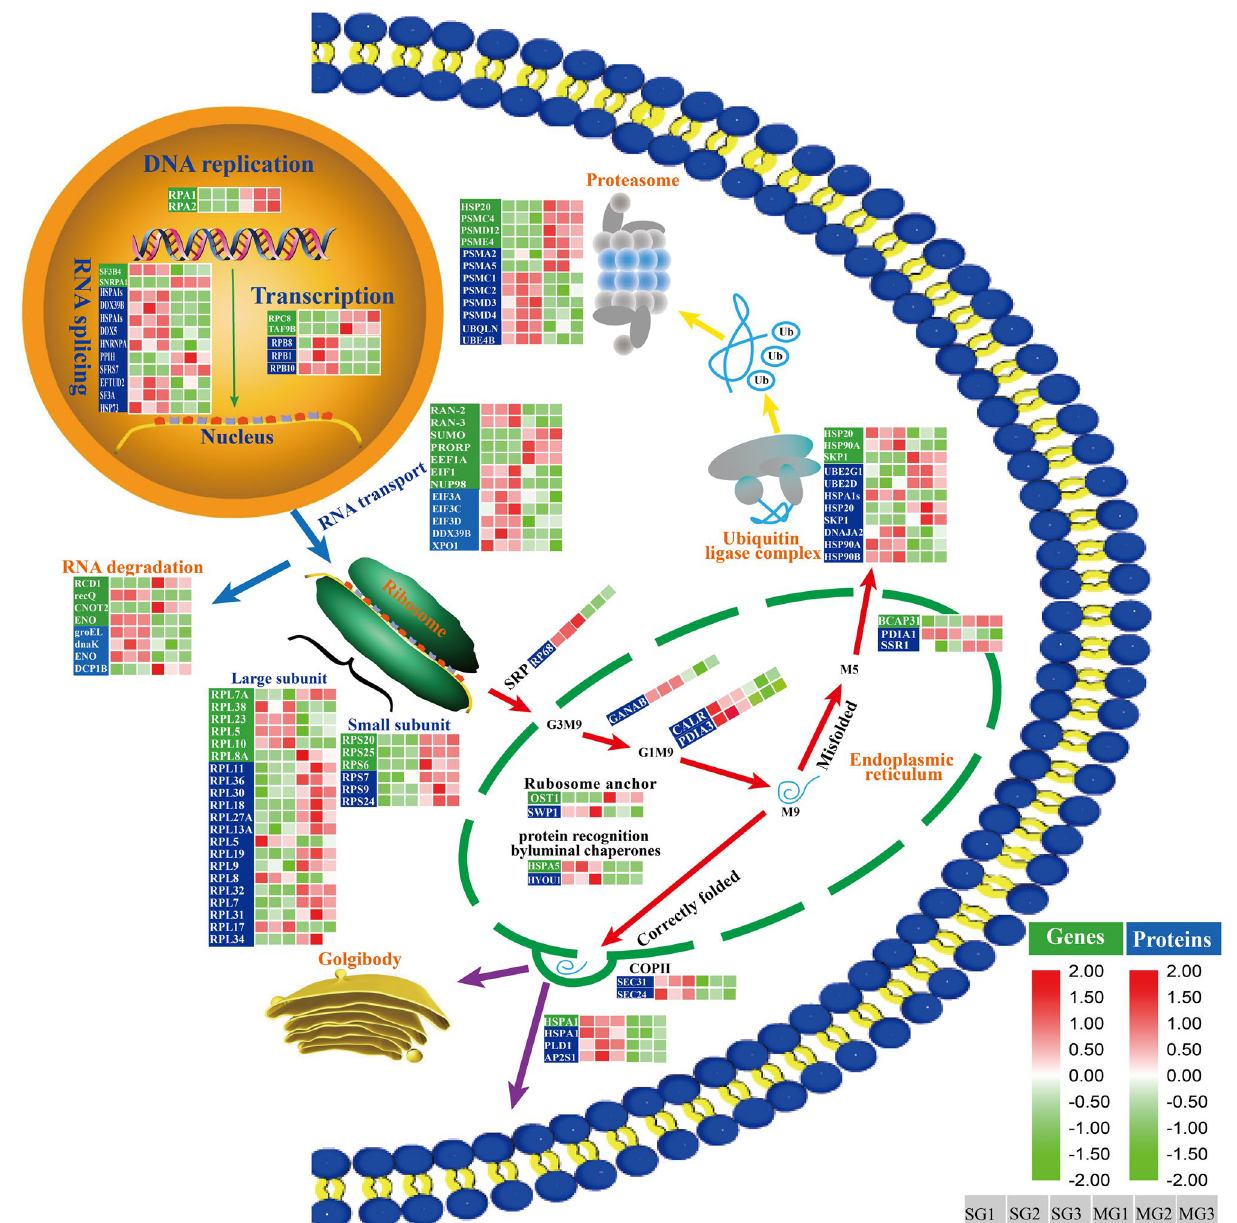
Figure 7. Abundance patterns of transcripts and protein species involved in protein assembly and processing of NIL-723 and NIL-1010. White characters with a green background represent genes, whereas white characters with a blue background represent protein species. For each gene or protein, the blocks represent expression levels in replications 1, 2, 3 of SG and MG from left to right. The expression value was log 2 transformed. Red represents up-regulated and green represents down-regulated. The whole path was drawed by software Adobe illustrator (AI, CC 2019, https:// www. adobe.